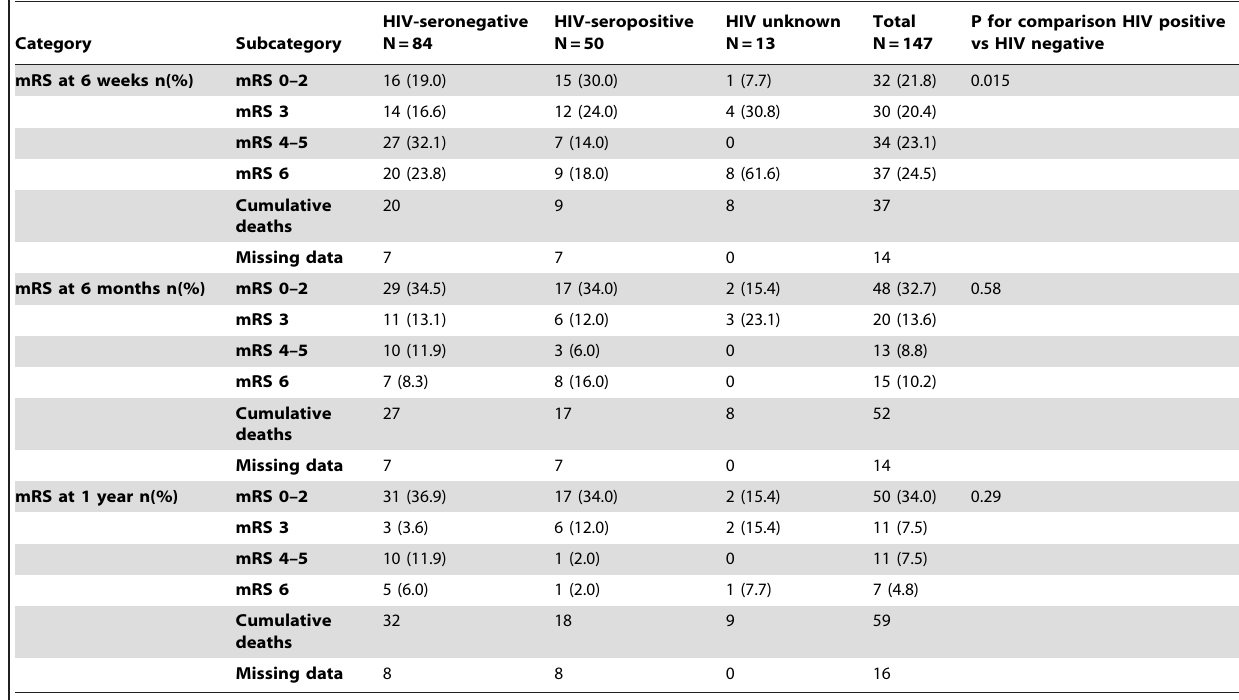
Table 2. Functional outcome and